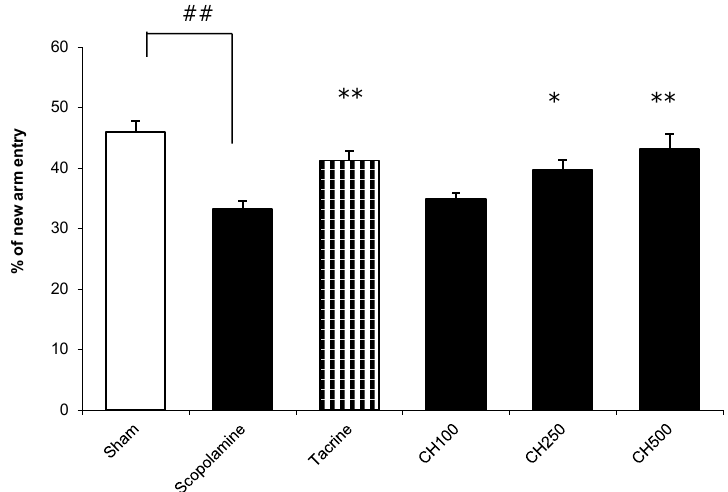
Figure 5. The effect of tacrine (at a dose of 10 mg/kg/day) and root-bark extract of CH (at doses of 100 (CH100), 250 (CH250) and 500 (CH500) mg/kg/day on scopolamine-induced impairment of spatial memory in a modified-Y-maze test. The percentage of time spent by mice in the new arm of a Y-maze task was measured 14 days after chronic extract treatment. The bars indicate means ± SEMs ( n = 10). One-way ANOVA and Turkey’s post hoc analyses were used for determination of statistical significance. ## p < 0.01 versus the control; * and ** p < 0.05 and 0.01 versus the scopolamine-treated mice, respectively.